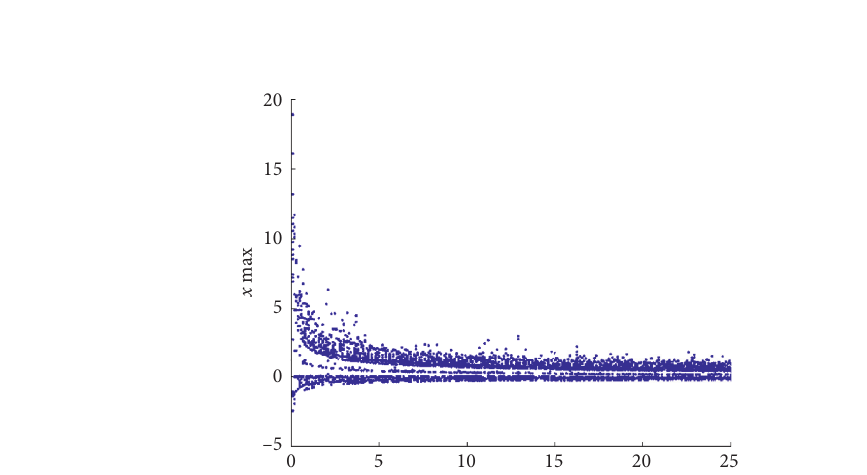
Figure 8: Phase portraits with the order α � 0 . 95.